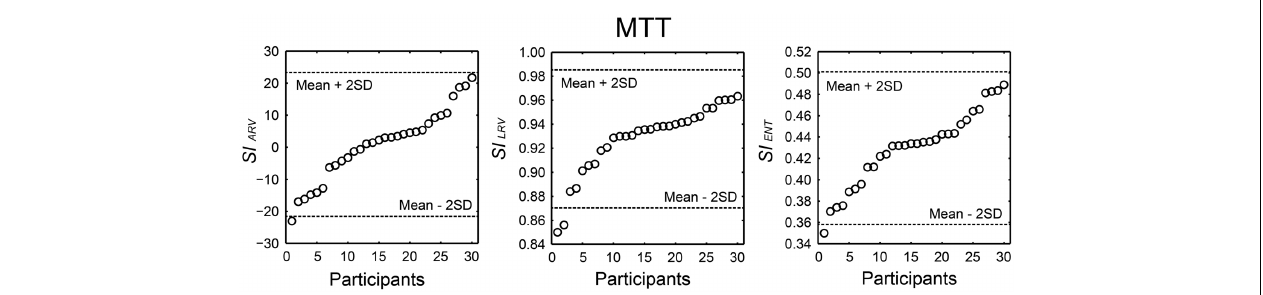
participants performing the music tapping test (MTT). Horizontal dashed lines indicate cut-off scores (mean ± 2 SD ). The participant’s order is sorted from smallest to